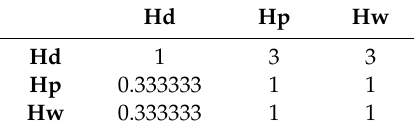
Table 12. Comparison matrix of the criteria for the determination of the integrated hazard.